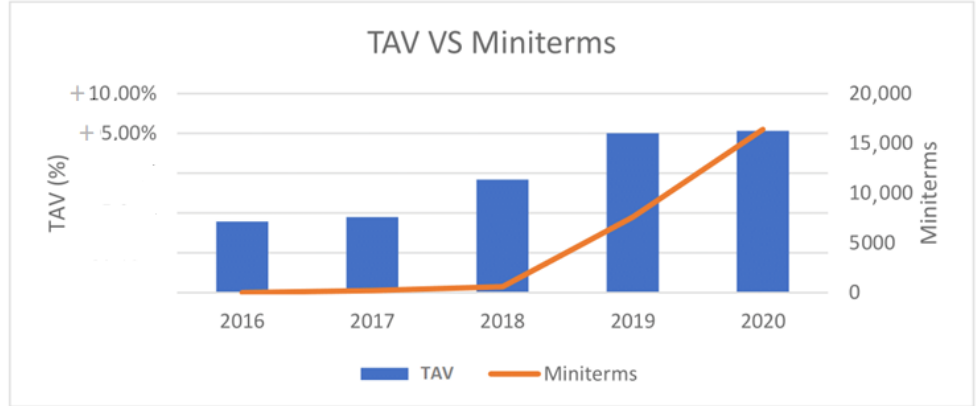
Figure 3. Improvement in production indicator (TAV) vs. mini-terms installed.